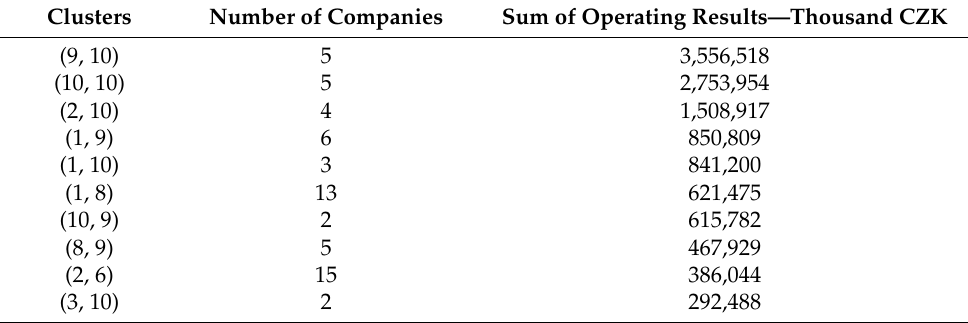
Table 23. Table of ten clusters with the highest sum of OR for the year 2017.